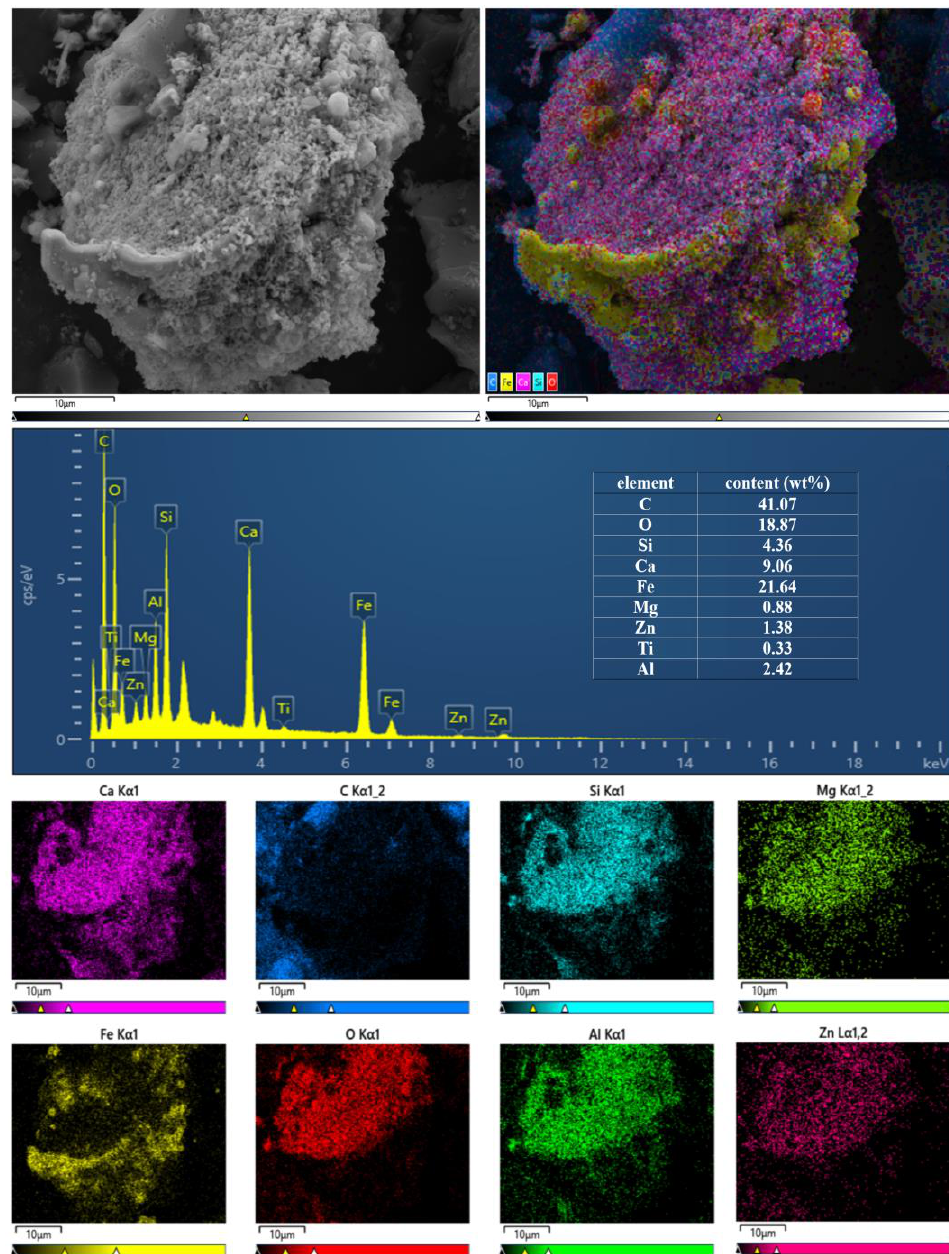
Figure 8. EDS and SEM of the micro electrolytic composite material prepared at 1273.15 K. Figure 9 displays the UV-VIS spectral variation during methyl orange degradation.